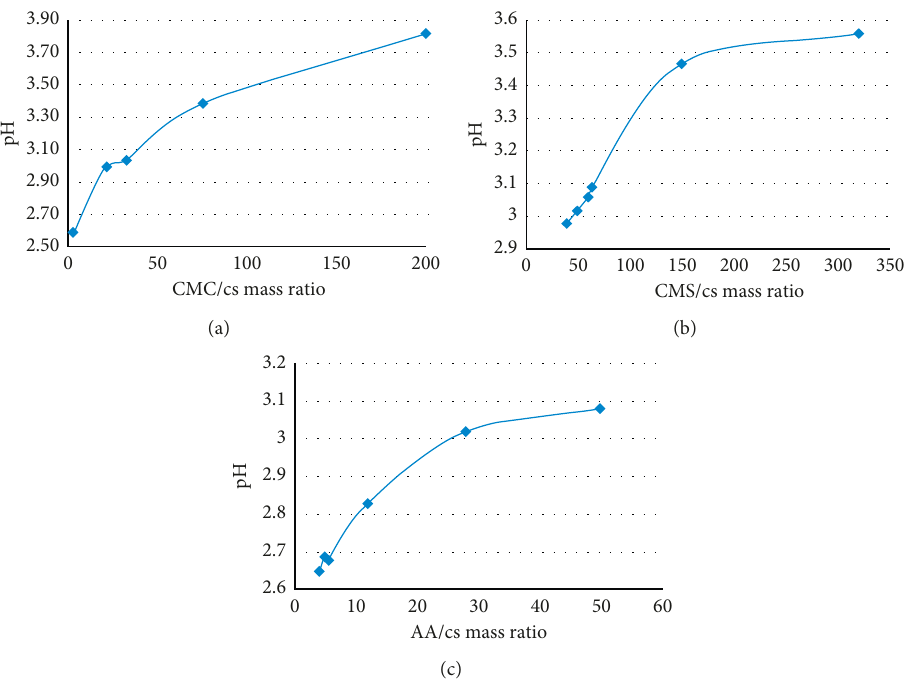
Figure 10: Effect of polymer-polymer ratio on pH of the final solution (a) CMC/CS, (b) CMS/CS, and (c) AA/CS.